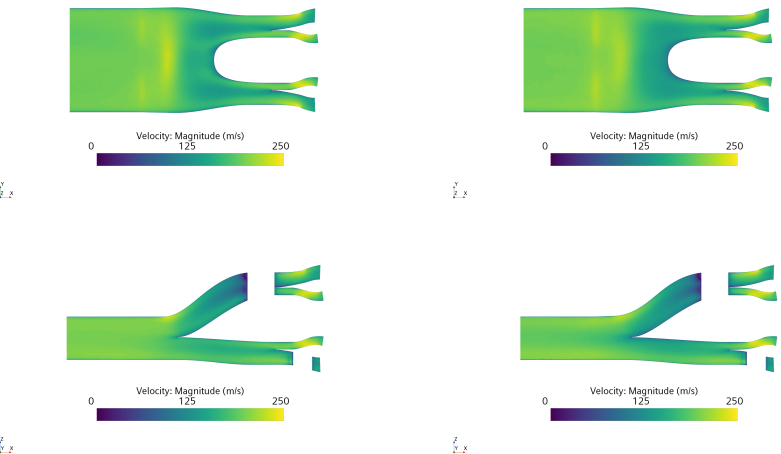
Figure 15. Velocity patterns comparison between initial ( left ) and final ( right ) 3D geometries. The top cut is given by the intersection of the geometry and the plane Z = − 0.5. The bottom cut is given by the intersection of the geometry and the plane Y = 0 (symmetry plane).